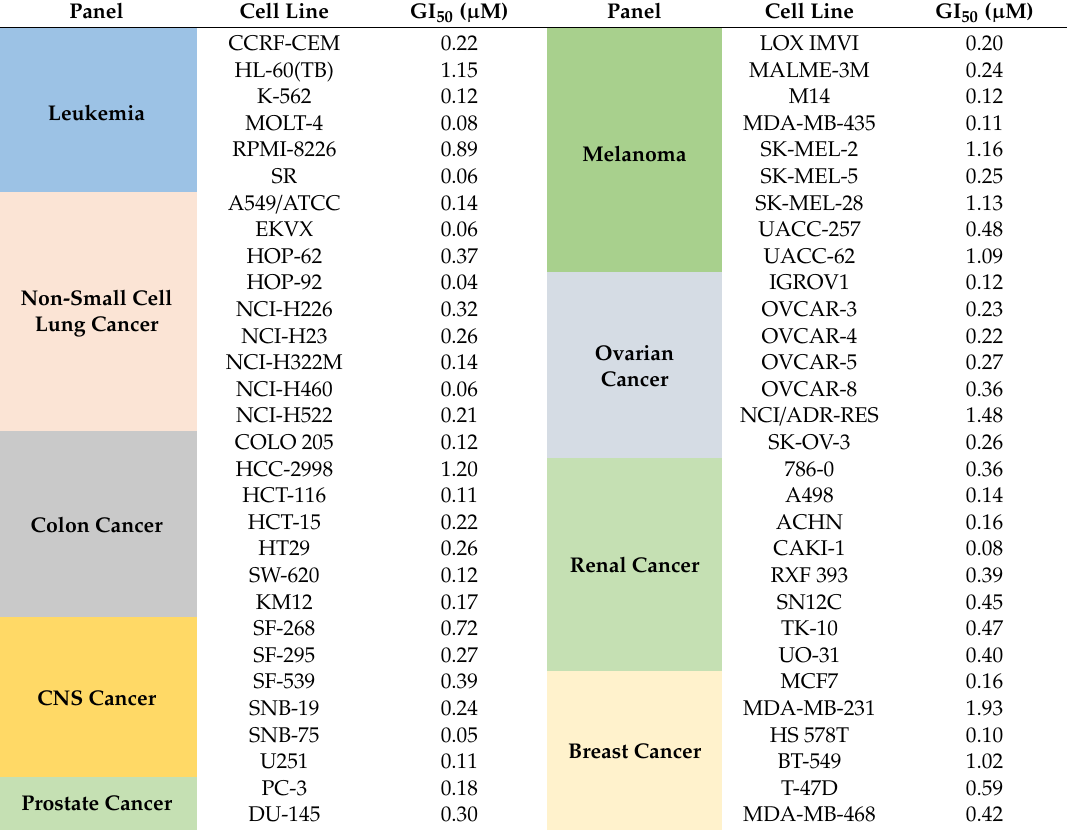
Table 6. In vitro antiproliferative activity of compound 8t from NCI60